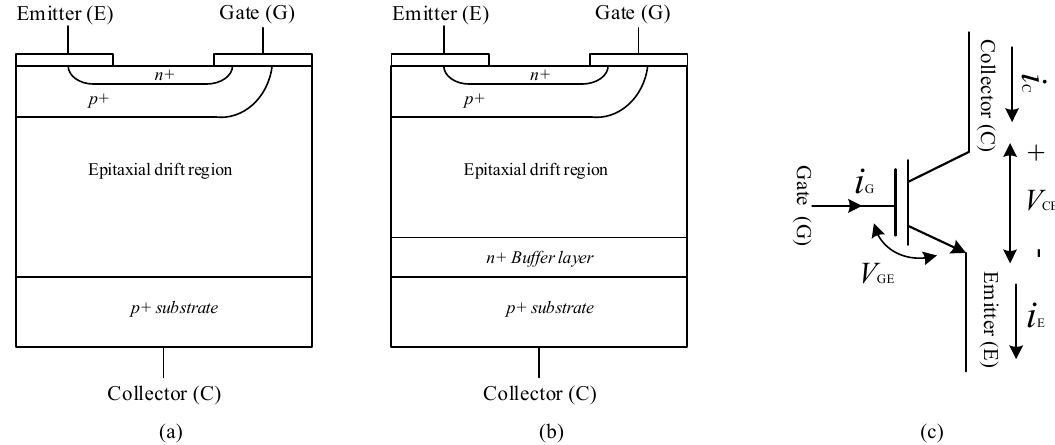
Figure 7. Diagrams showing the ( a ) the non-punch-through (NPT) structure of an IGBT ( b ) the punch- through (PT) structure of an IGBT and ( c ) the circuit schematic of an IGBT